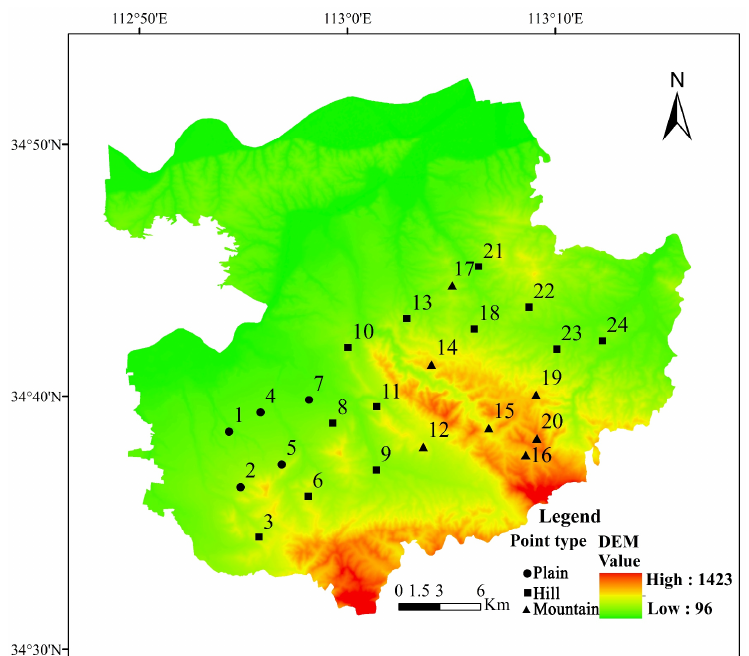
Figure 2. Distribution of 24 sampling sites in the studied area. Table 1. Landscape indices in different buffer